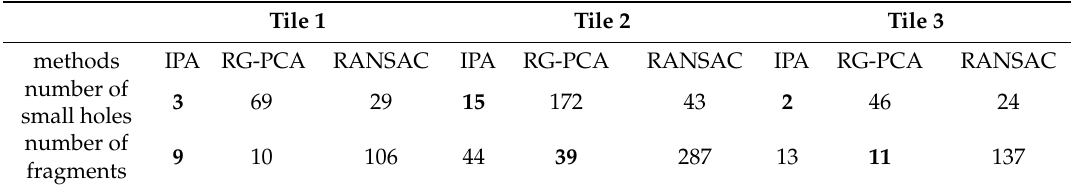
Table 1. Qualitative evaluations for planar surface extraction results.